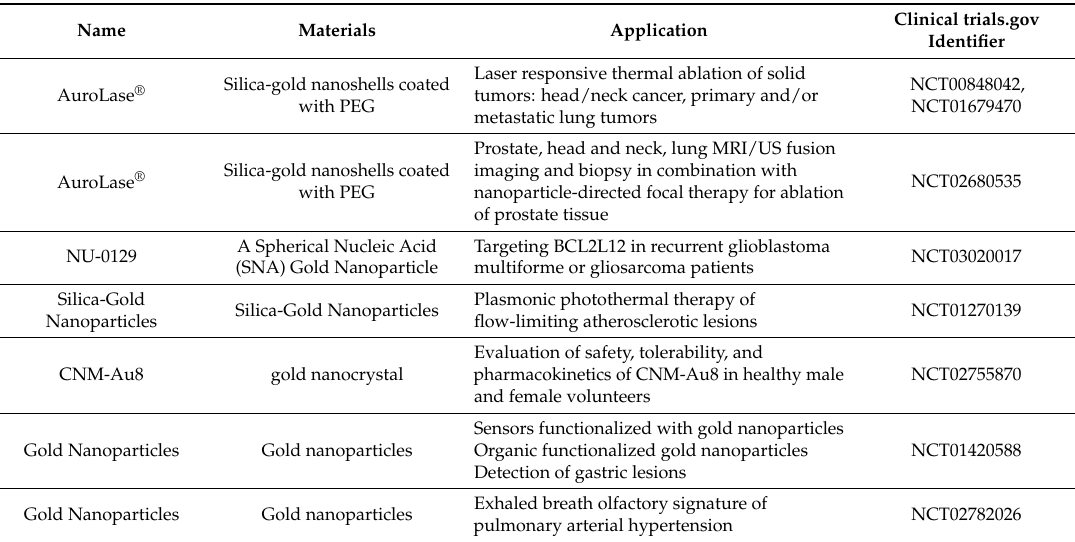
Table 2. Lists of clinical trials of gold